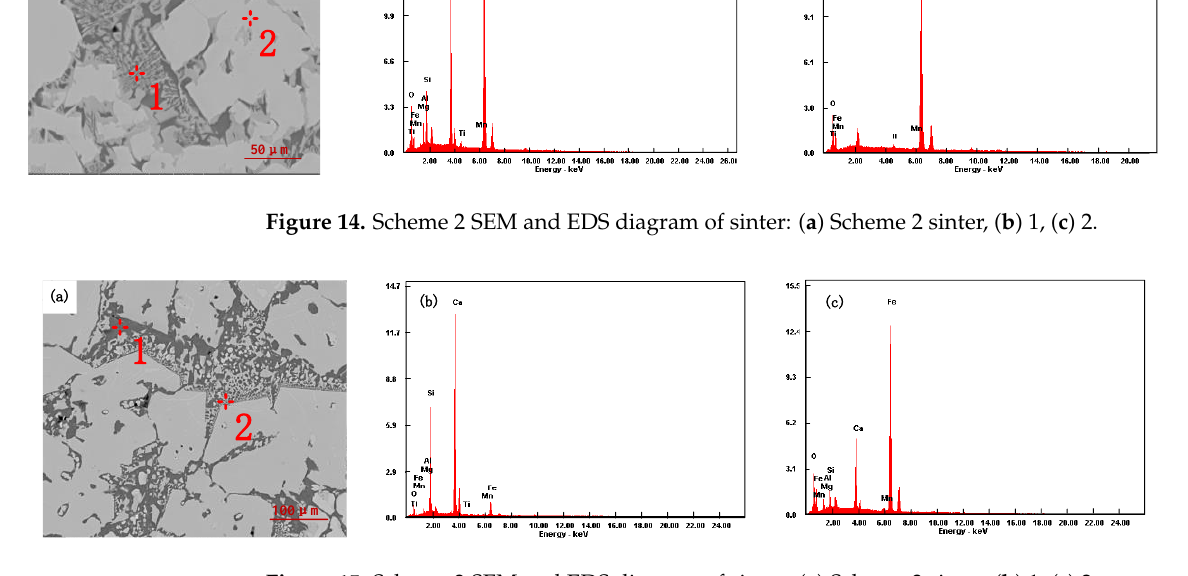
Figure 15. Scheme 3 SEM and EDS diagram of sinter: ( a ) Scheme 3 sinter, ( b ) 1, ( c ) 2.